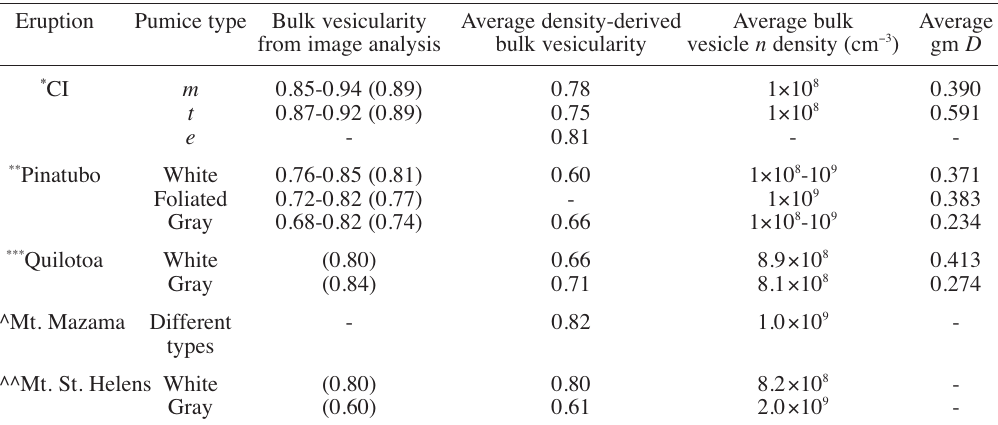
Table III. Vesicle measurements from explosive silicic eruptions.